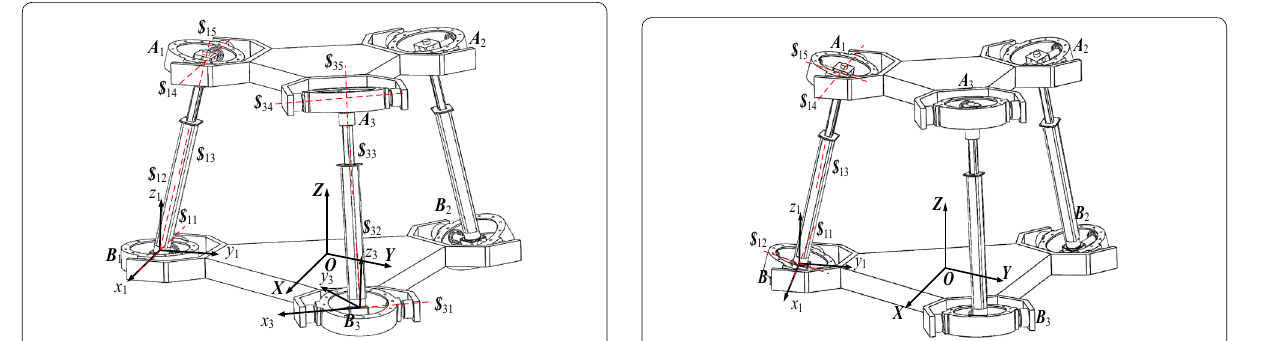
Figure 12. 1(rA-1)P(rA-1)-2(rA-6)P(rA-1) Figure 13. 3(rA-4)P(rA-4) with pure